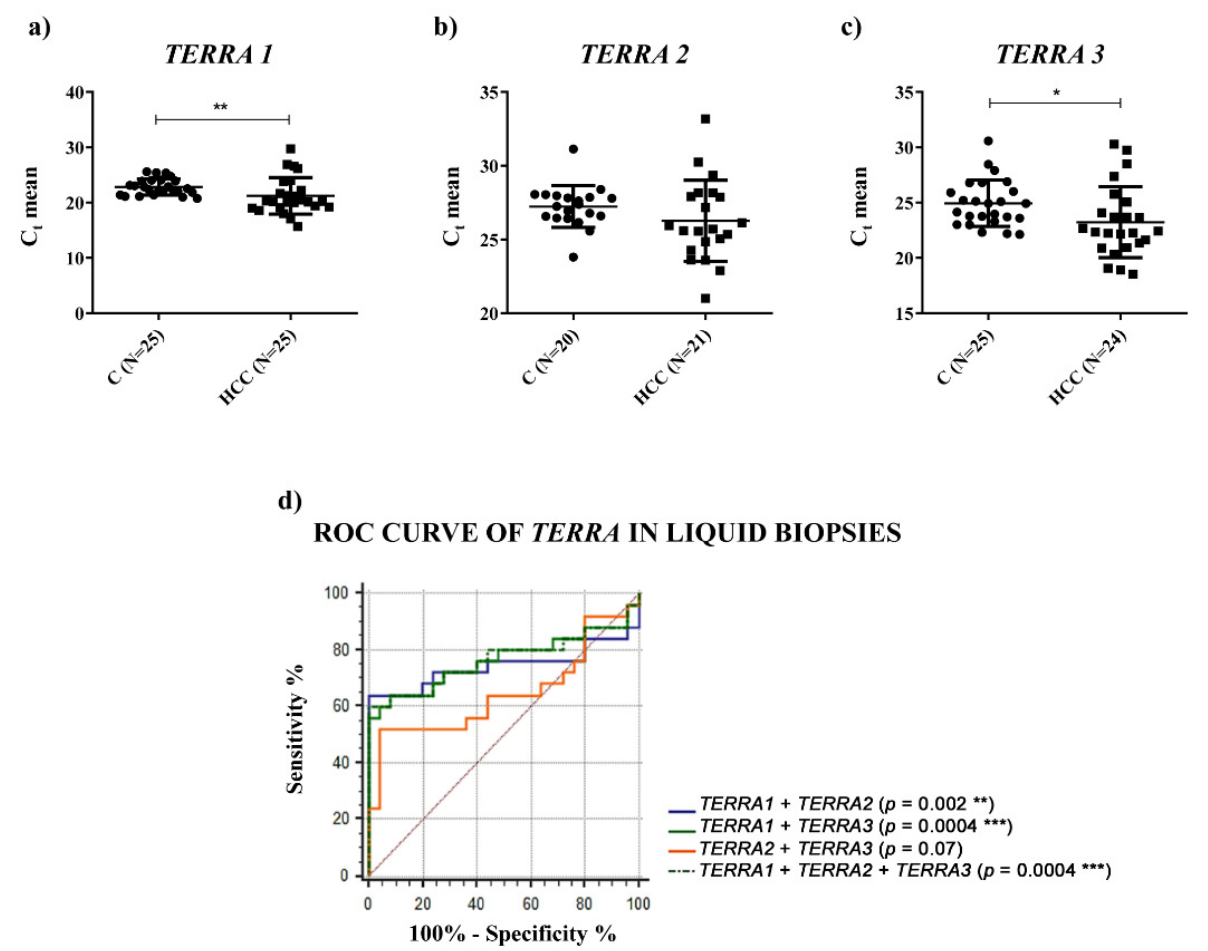
Figure 4. Plasma levels of TERRA . ( a – c ) TERRA levels in terms of C t in plasma of healthy (C) and HCC individuals. TERRA expression from different telomers was analyzed using specific primers ( TERRA 1 = hTel 1_2_10_13q; TERRA 2 = hTel 15q; TERRA 3 = hTel XpYp). Parametric unpaired two-tailed t -test. ( d ) ROC curve analysis of TERRA to discriminate HCC from healthy individuals. * p < 0.05, ** p < 0.01, *** p < 0.001. Table 2. Diagnostic performance of circulating TERRA in plasma.